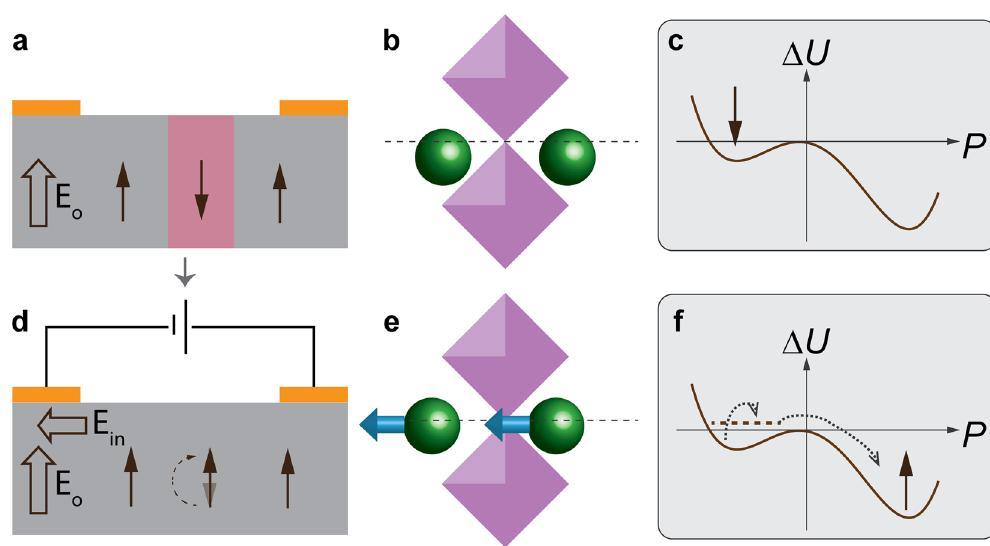
Figure 6. Ferroelectric switching triggered by weak perturbation. ( a,d ) Illustrations of the polarization rotation induced jointly by external in-plane field ( E ) and the up direction built-in field ( E ) in the region poled by in 0 positive probe bias. ( b,e ) Displacements of Na ions (green) with respect to the MnF 6 octahedral (violet) ( b ) after probe poling and ( e ) under an external in-plane field. The octahedral tilts and rotations were removed to schematically show only the Na-site behavior, which is the one responsible for the ferroelectricity in NaMnF 3 . ( c,f ) Double well model showing ( c ) the down polarized state weakened by the built-in field (E 0 ), and ( f ) polarization switching triggered by perturbation from external in-plane